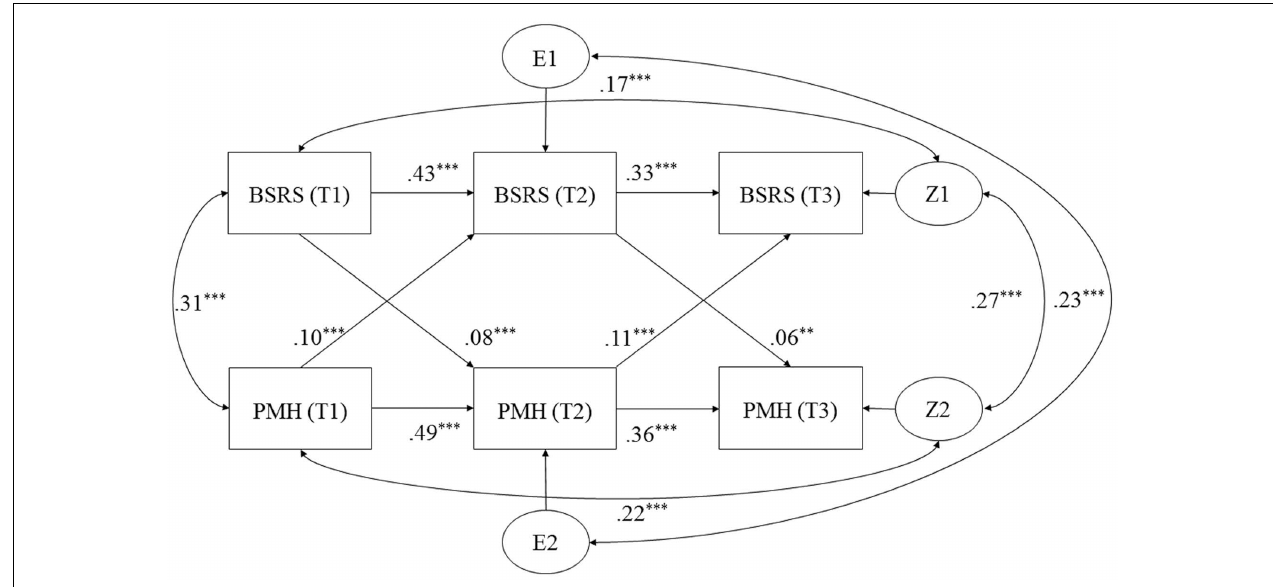
FIGURE 1 | Cross-lagged panel model for social rhythm measured by Brief Social Rhythm Scale (BSRS) and positive mental health measured by Positive Mental Health Scale (PMHS). T1, baseline; T2, 1-year-follow-up; T3, 2-year-follow-up; double-headed arrow, correlation; one-head arrow, regression. E1, E2, Z1, and Z2 represent the residual errors for BSRS (T2), PMHS (T2), BSRS (T3), and PMHS (T3), respectively. ∗∗ p < 0.01; ∗∗∗ p <